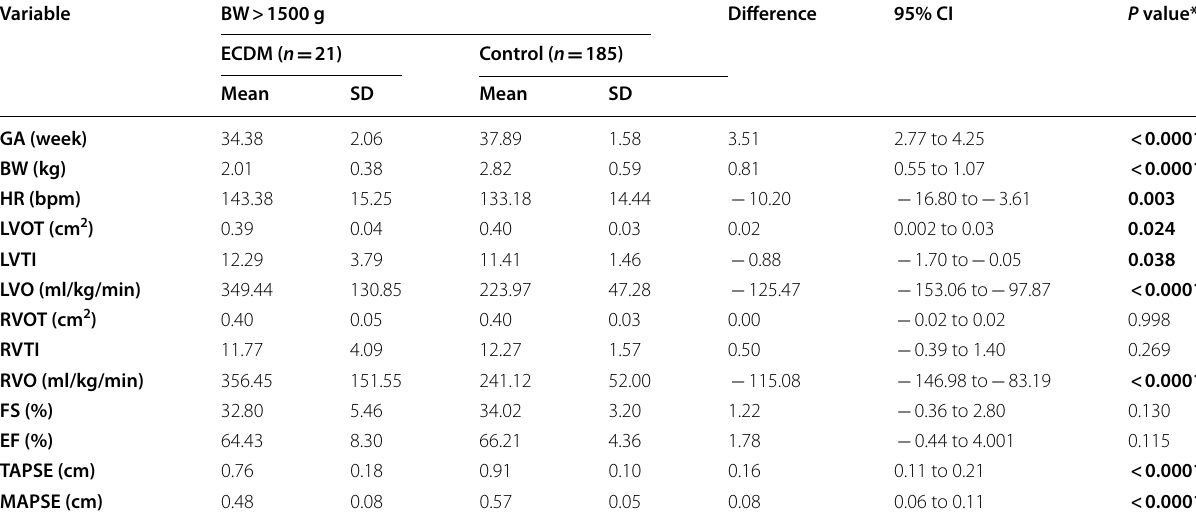
Table 3 Comparison of echocardiography‑directed management (ECDM) and control groups in the cohort of patients with birth weight > 1500 g at baseline